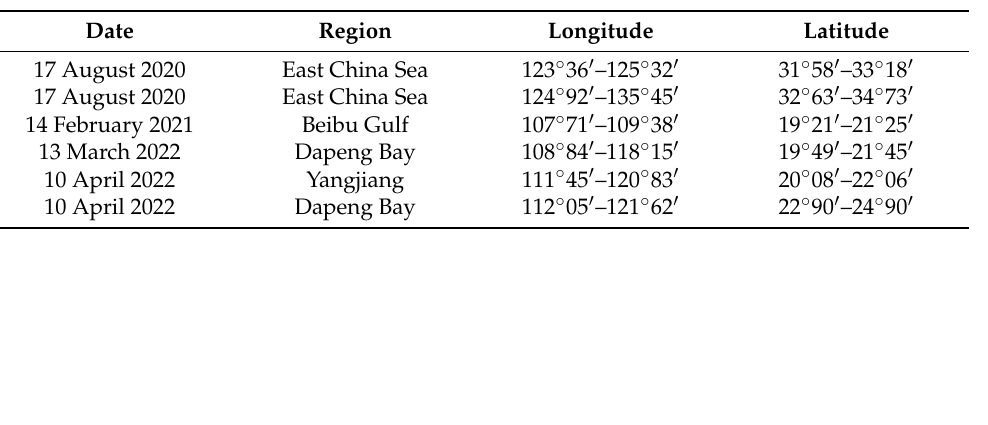
Table 1. Information on NSBs in